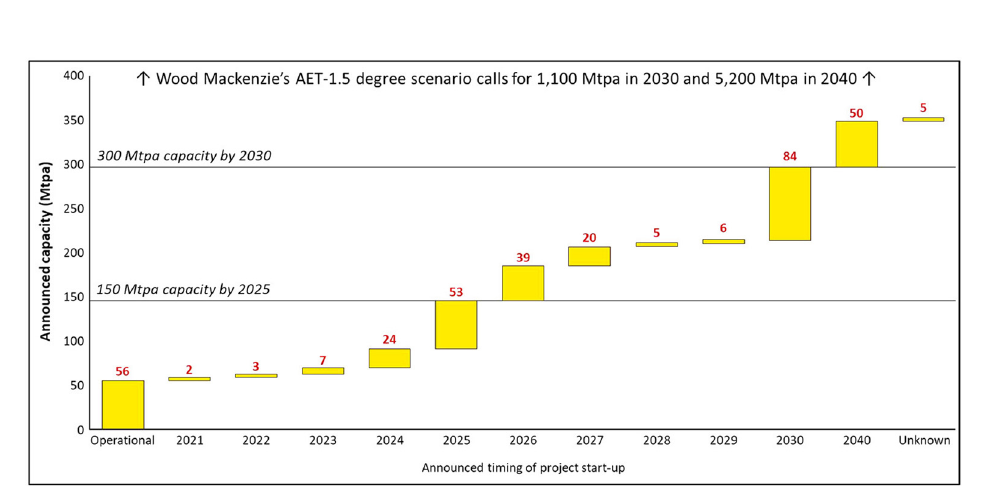
Fig. 9. – Planned carbon capture capacity additions by year of announced start-up [1].